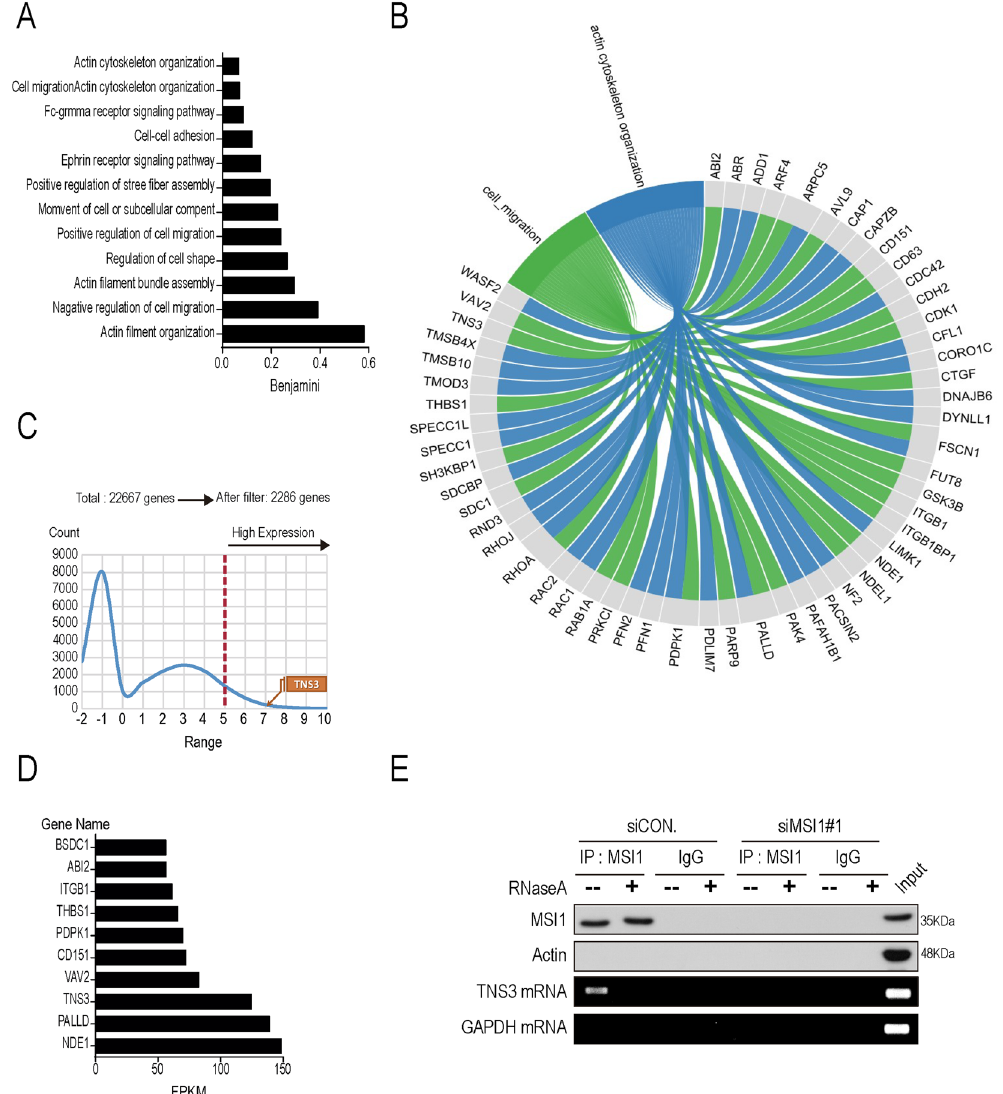
Figure 3. Gene ontology (GO) and pathway analyses for MSI1 targets distribution in actin rearrangement. Ribonucleoprotein immunoprecipitation sequencing (RIP-seq) of MSI1-associated RNAs were performed in 05MG cells. ( A ) Gene ontology (GO term) enrichment analysis was conducted by DAVID software per the biological processed. ( B ) MSI1-immunoprecipitated mRNAs are enriched for protein-protein interaction network, of which the top-ranked genes from the GO terms were listed. ( C ) Non-significant genes were cut off, narrowing down the original 22667 genes into 2286 target genes. TNS3 was found in the highly expressed pool of genes. ( D ) The top 10 significantly changed genes were analyzed by REVIGO (http://revigo.irb.hr/) and listed in the chart. The numbers on each graph showed the corresponding GO term of cell migration and its read counts by FPKM (fragments per kilobase of exon per million fragments mapped). ( E ) Endogenous MSI1 was precipitated from 05MG cells treated without or with RNaseA (10 mg/ml). The precipitated complexes were subjected to RT-PCR to assess TNS3 mRNA levels and by Western blotting to confirm the MSI1 precipitation, of which the uncropped blots were demonstrated in Supplementary Figure